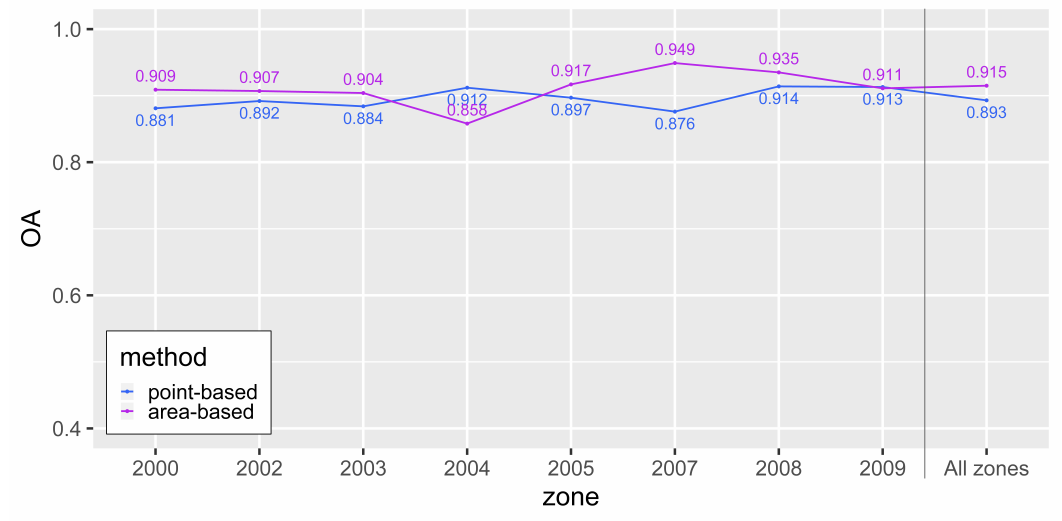
Figure 13. OA values for the point-based and area-based assessment methods per zone of